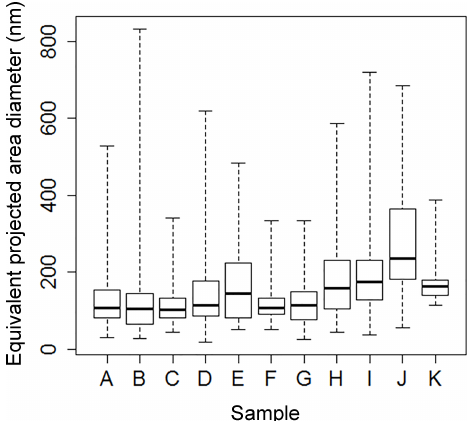
Figure 3. Box plot of particle size (equivalent projected area diam- eter D pa ) . Lower and upper quartiles appear as a box, and minimum and maximum values as whiskers.